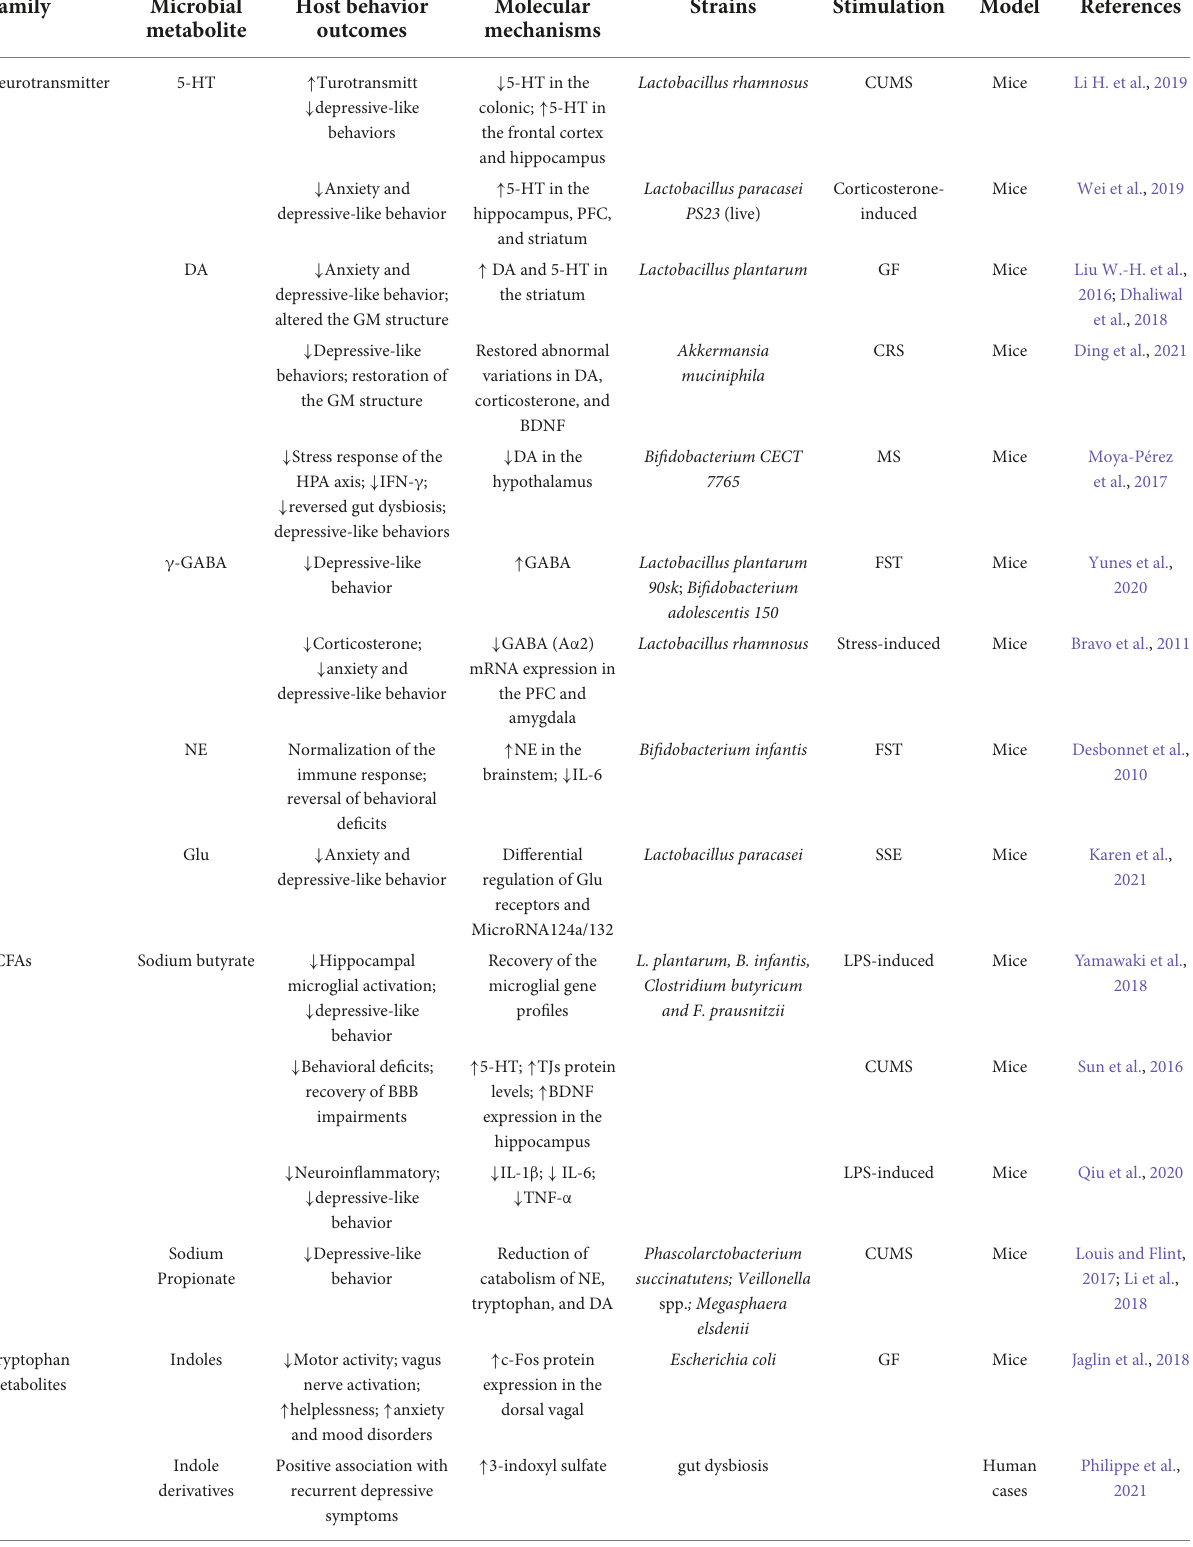
TABLE 1 Studies investigating the biological link of microbial metabolites on depressive-like behavior.